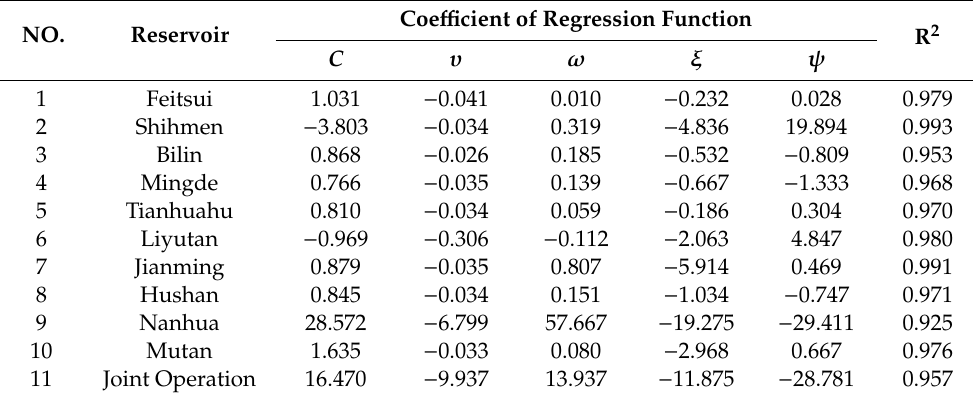
Table 9. The estimated WSRI liner regression function of each reservoir.